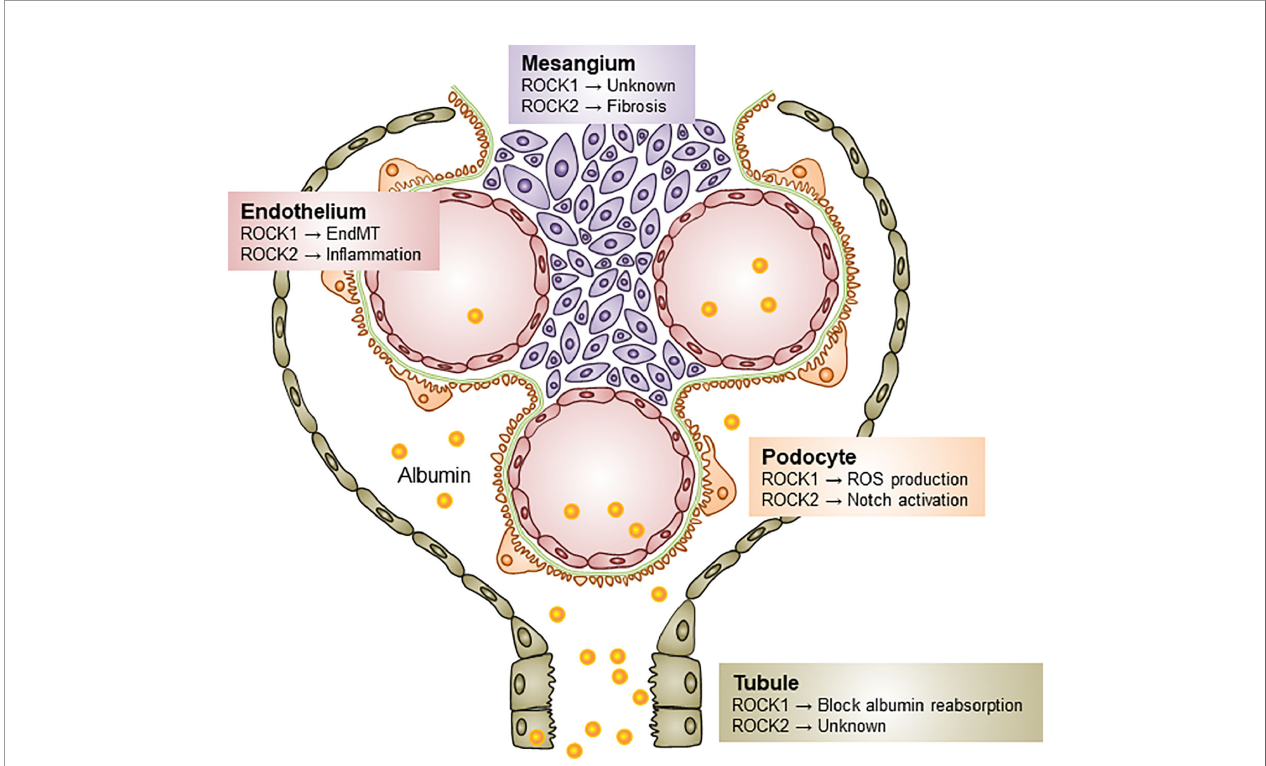
FIGURE 2 | Distinct roles of ROCK isoforms in diabetic kidney disease. Both ROCK1 and ROCK2 contribute to the pathogenesis of DKD via different mechanisms. ROCK1 activation induces podocyte ROS production, EndMT, and blocks albumin endocytosis in tubular epithelial cells. Little is known about the role of ROCK1 on the mesangial biology, but ROCK2 elevation induces as the progression of mesangial expansion, Notch activation in podocytes, and endothelial in fl ammation. ROS, Reactive oxygen species; EndMT, Endothelial-to-mesenchymal